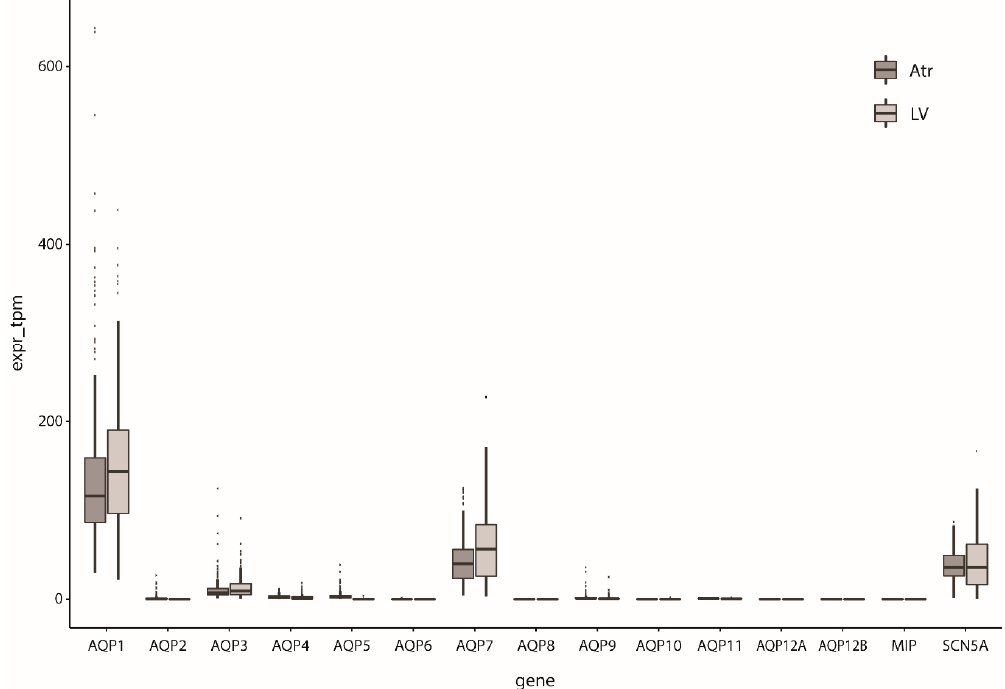
Figure 1. Relative expression of AQPs in human left ventricular (LV) and atrial tissue (Atr). The main cardiac sodium channel SCN5A is shown for comparison; expr_tpm indicates the number of transcripts detected for each gene per million transcripts, normalized for gene length. Expression data obtained from [33,34].